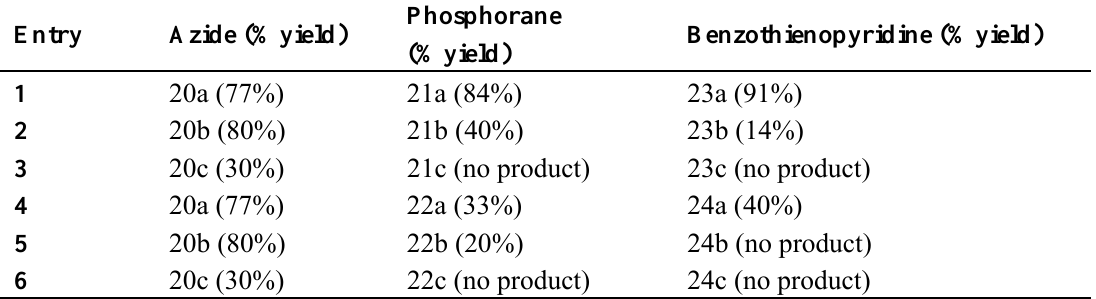
Table 1. Synthesis of 5-amino (or